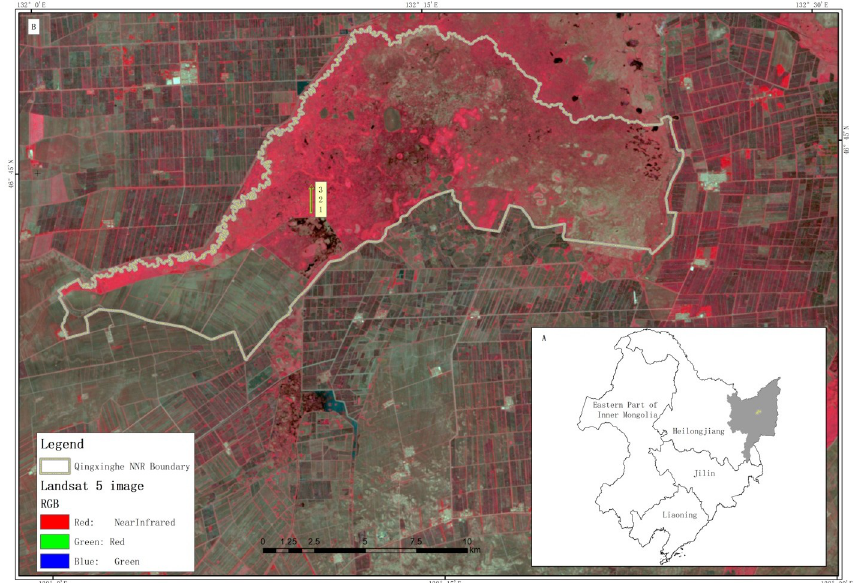
Fig 1. Bottom at the right corner is the location of Northeast China (A) and shaded grey and yellow dot is Sanjiang Plain and Qixing River Wetland National Nature Reserve, respectively. The enlarged map at the top (B) is Qixing River Wetland National Nature Reserve and 1, 2, 3 are the sampling